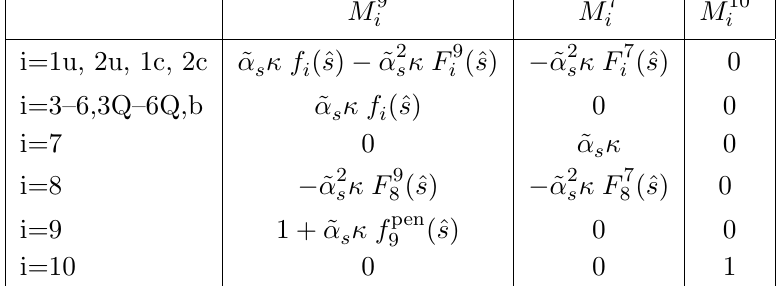
Table 1 . Matrix elements M A